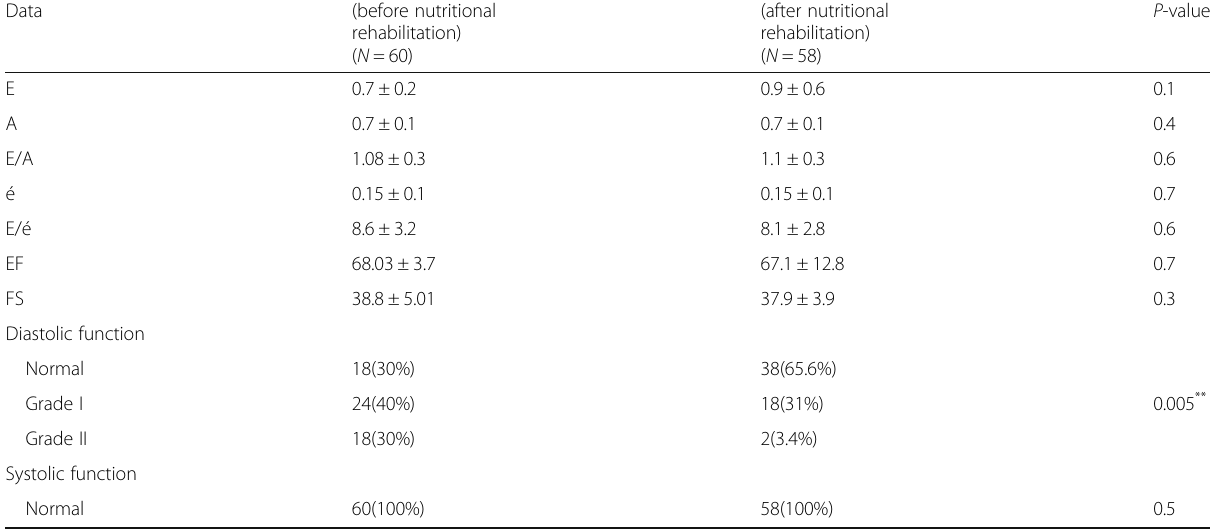
Table 3 Comparison between Tissue Doppler findings in children with SAM before and after nutritional rehabilitation